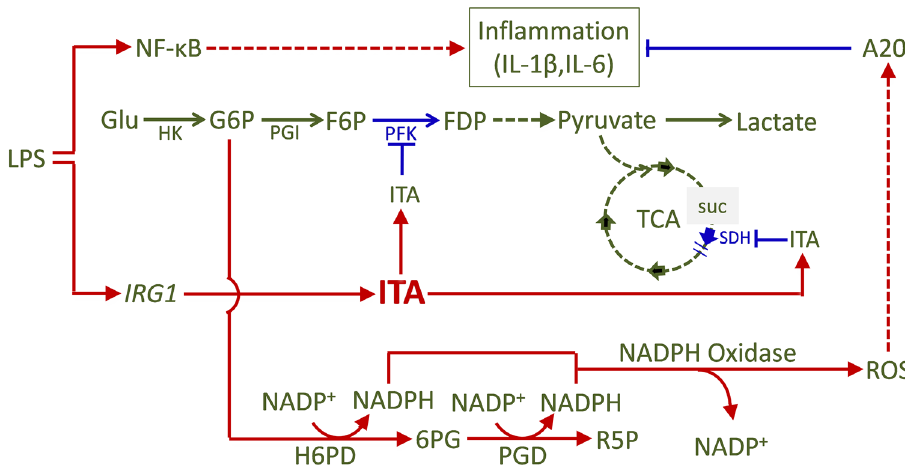
Figure 6. Schematic representation of the mechanism of anti-inflammatory effects of itaconic acid/ IRG1 (Drew with Microsoft Office Powerpoint 2007). Glu, glucose; HK, Hexokinase; G6P, glucose-6-phosphate; PGI, glucosephosphate isomerase; F6P, fructose-6-phosphate; PFK, phosphofructo kinase; FDP, fructose-1,6- diphosphat; H6PD, hexose-6-phosphate dehydrogenase; 6PG, 6-phosphogluconate; PGD, phosphogluconate dehydrogenase; R5P, ribulose-5-phosphate; ROS, reactive oxygen species; A20, TNFAIP3, TNF alpha induced protein 3; TCA, tricarboxylic acid cycle; SUC, succinate; ITA, itaconic acid; SDH, succinate